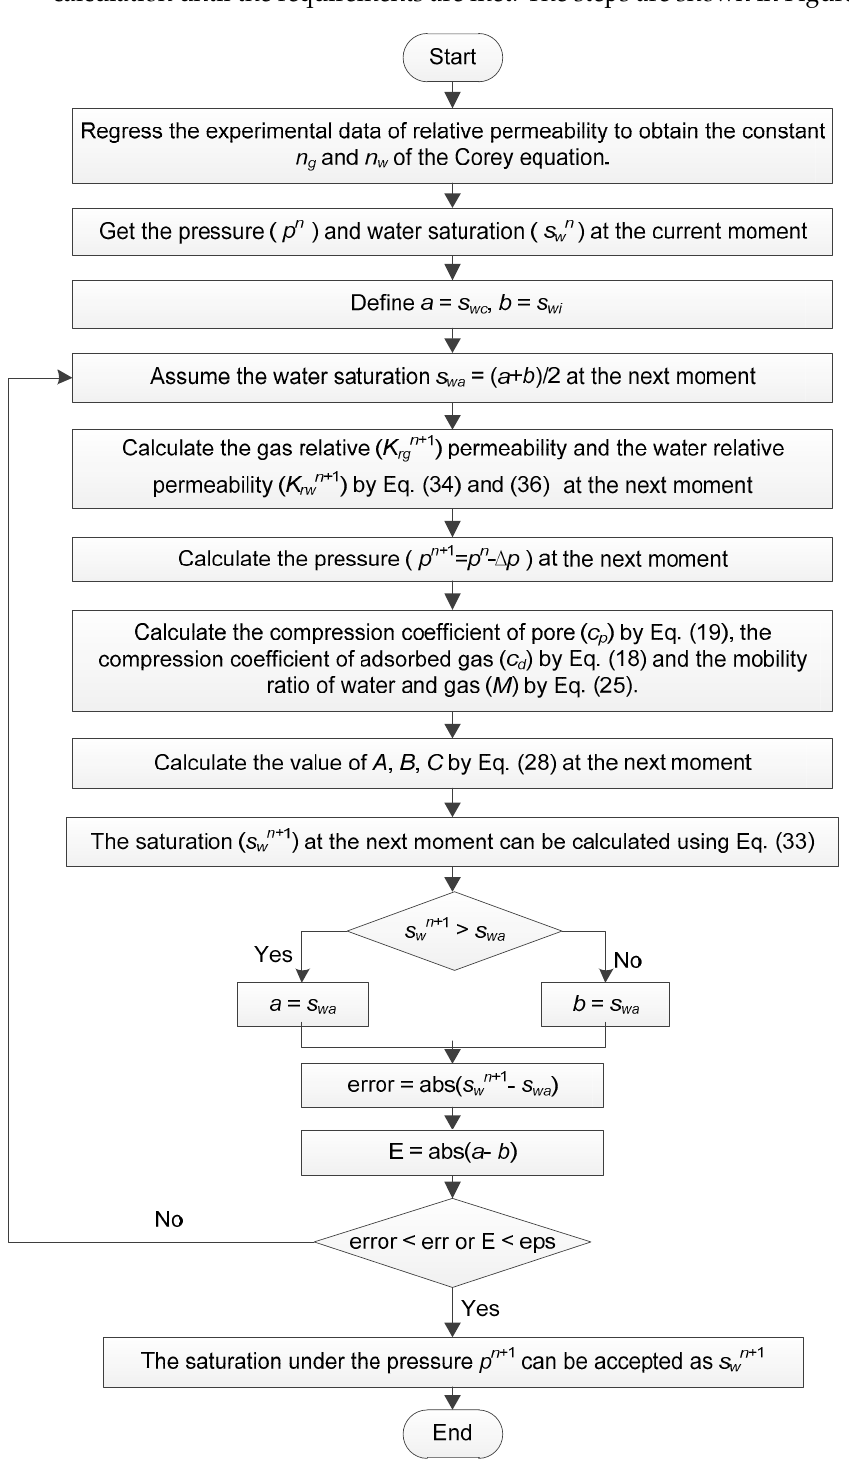
Figure 1. Calculation flowchart of the connection between pressure and saturation.